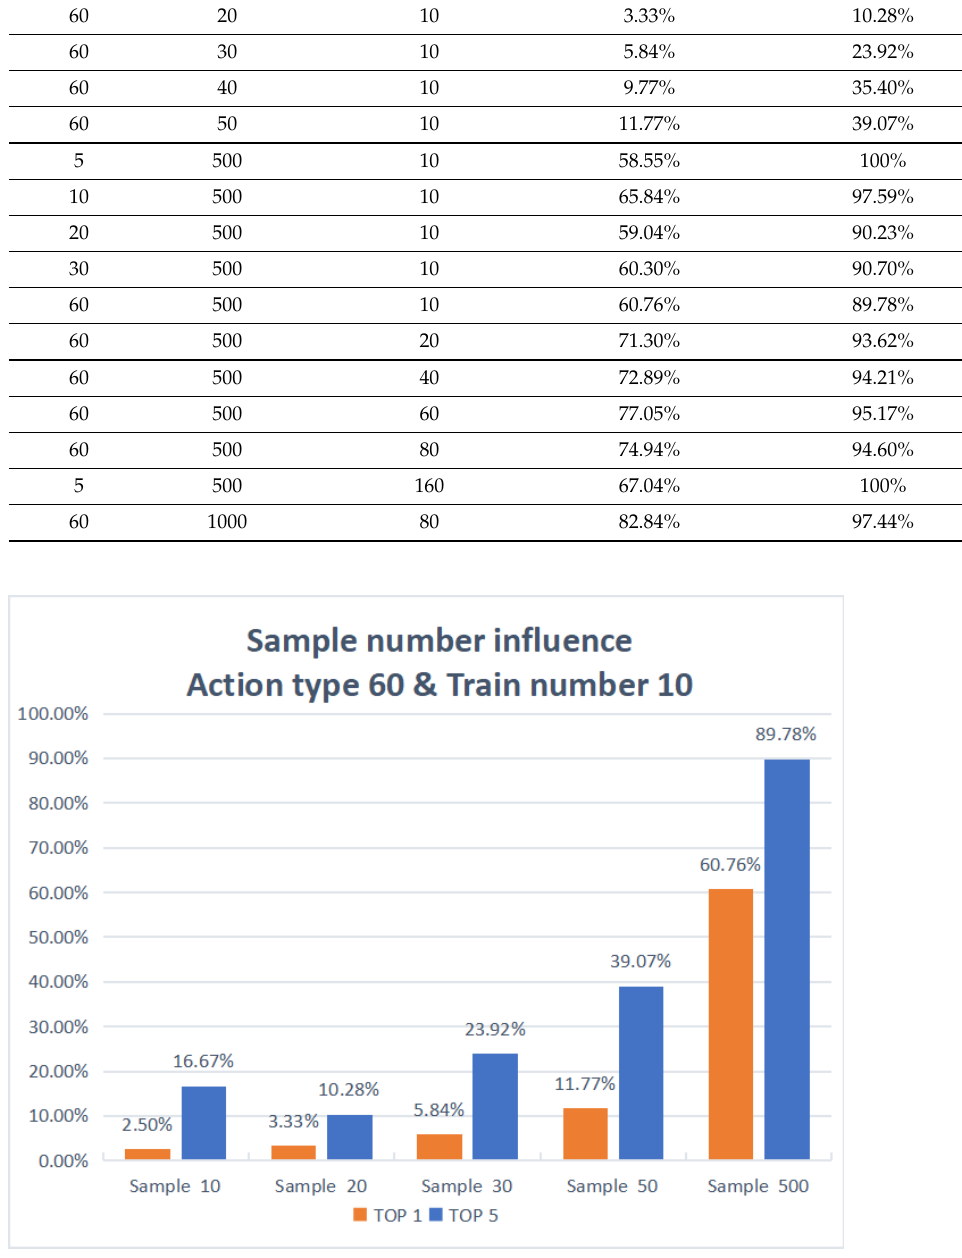
Figure 7. Histogram of the effect of Sample